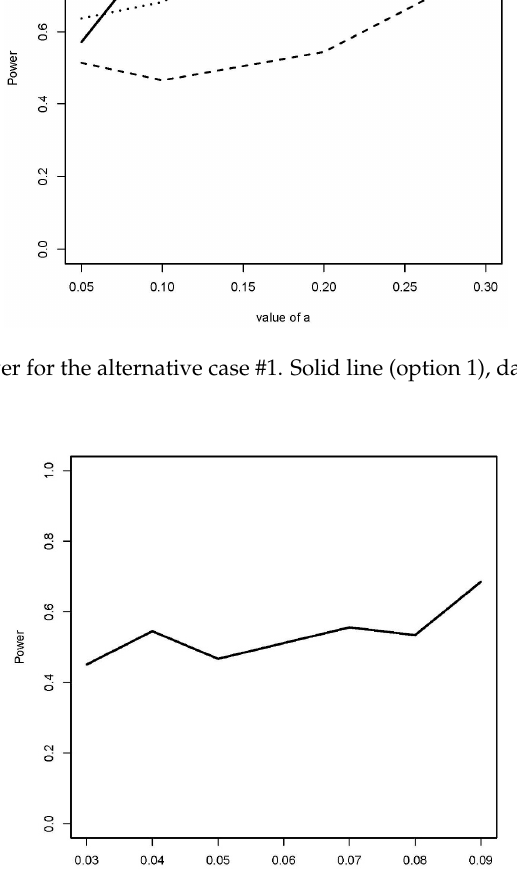
Figure 6. Estimated power for the alternative case #2.